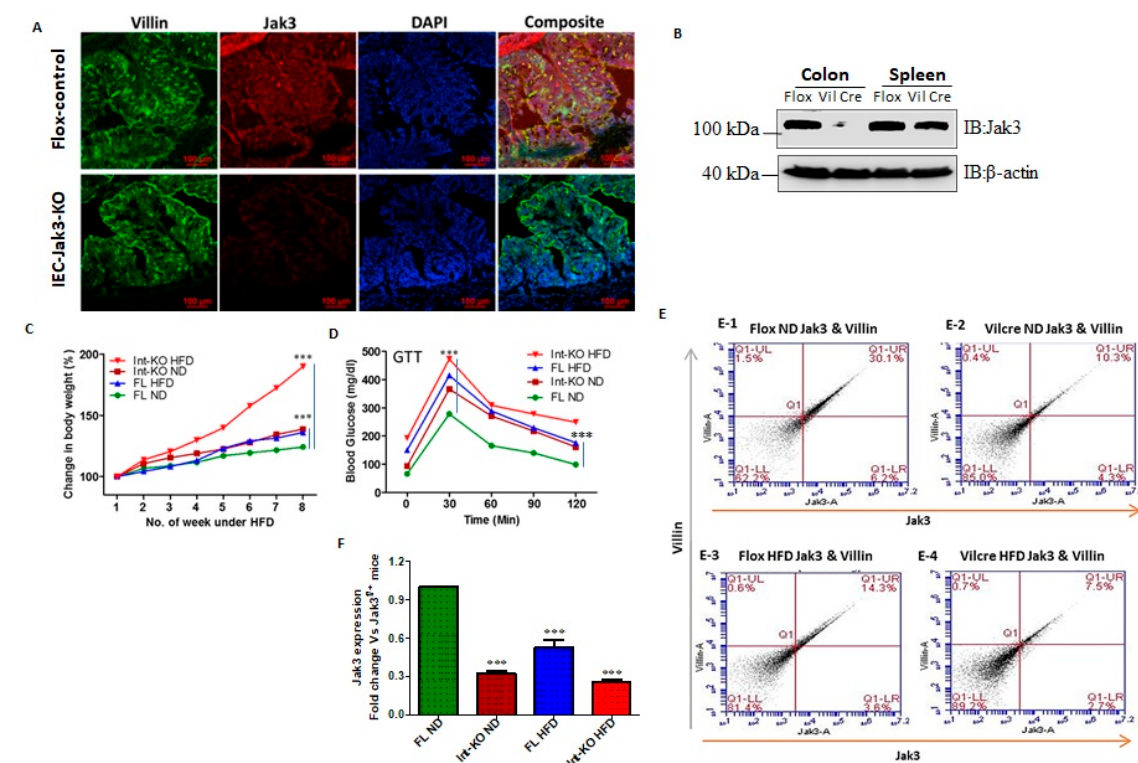
Figure 2. Intestinal epithelial cell (IEC) deficiency of Jak3 predisposes to exaggerated symptoms of HFD-induced obesity and glycemic dysregulation. ( A ), Genetic manipulation shows IEC deficiency of Jak3. Colonic tissue sections from floxed Jak3 (jak3f/f) or IEC-Jak3-KO (vil1-Cre- jak3f/f) were co-immunostained with IEC marker villin (green) and Jak3 (red) antibodies using DAPI as control for the nucleus. Representative images ( n = 10) are shown from each group ( n = 6). ( B ), Western blot analyses were performed using tissue lysates from floxed Jak3 and IEC-Jak3-KO mice for Jak3 expression (upper panel) using β -actin as control (lower panel). Representative blots ( n = 3) are shown. ( C ), Fluorescence-activated cell sorting (FACS) analysis is presented as four quadrant dot plots to determine the impact of HFD on IEC-Jak3 expression by determining the double positive cells (Quadrant:UR) for IEC marker villin and Jak3 under ND or HFD. Jak3 positive cells are shown on the x axis and those of villin positive cells on the y axis. ( D ), Bar chart results following FACS experiments in “C” were repeated ( n = 5), and mean ± SD values are shown as bar graph for the comparative average cell counts for the indicated groups of mice. *** denotes p = 0.004 (Int-KO ND), p = 0.008 (FL HFD), p = 0.001(Int-KO HFD). ( E ), IEC deficiency of Jak3 predisposes to increased body weight. Vil1-Cre/ jak3f/f (Int-KO) or their littermate controls jak3f/f (FL) mice were cohoused and subjected to either ND or HFD. Body weights of co-housed Int-KO and their FL littermate males were plotted at the indicated intervals as a percentage of their body weight at the time of weaning ( n = 5/group). *** denotes p = 0.005 (Int-KO HFD), p = 0.05 (Int-KO ND). ( F ), IEC deficiency of Jak3 impairs the ability to restore blood glucose. Blood glucose concentrations in fasted mice were measured after intraperitoneal injection with 2 g/kg body weight of d-glucose followed by measuring the level of blood glucose at thew, indicating intervals post-injection ( n = 5/group). *** denotes p = 0.003 (Int-KO HFD), p = 0.05 (Int-KO